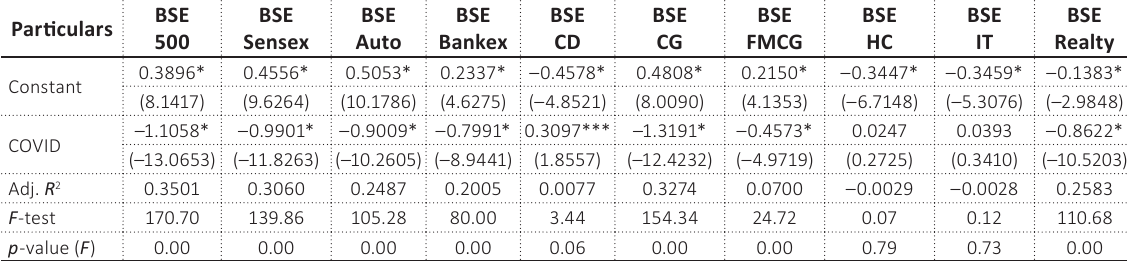
Table 5. Regression analysis: model 2 – for COVID-19 and skewness of the index returns